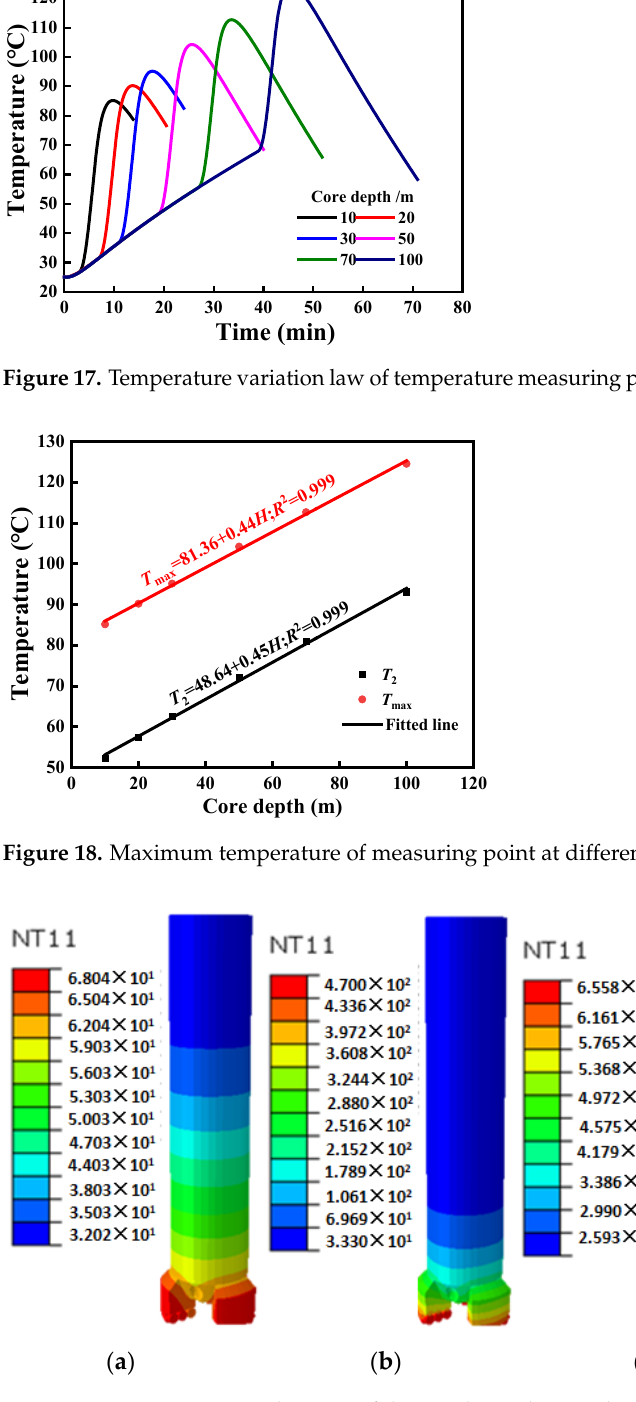
100 Figure 20. Temperature variations of measuring point during coring at different core depths in ZG. The temperature of measuring point on the core tube at the end of the second stage and the maximum temperature during coring in ZG both increased linearly with the core depth, which is shown in Figure 21.